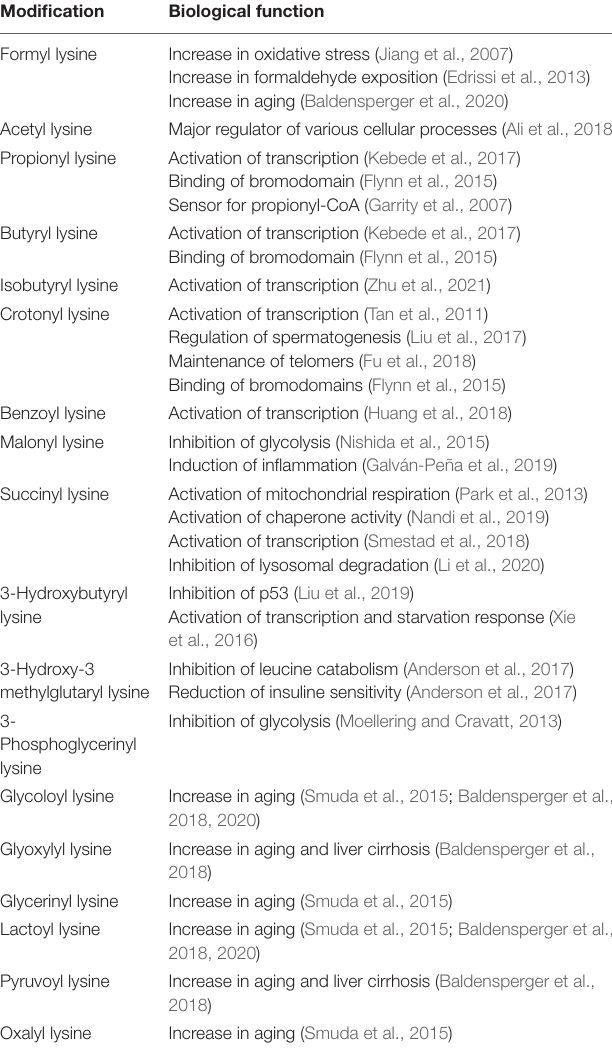
TABLE 1 | Acyl lysine modifications and their biological functions reported in